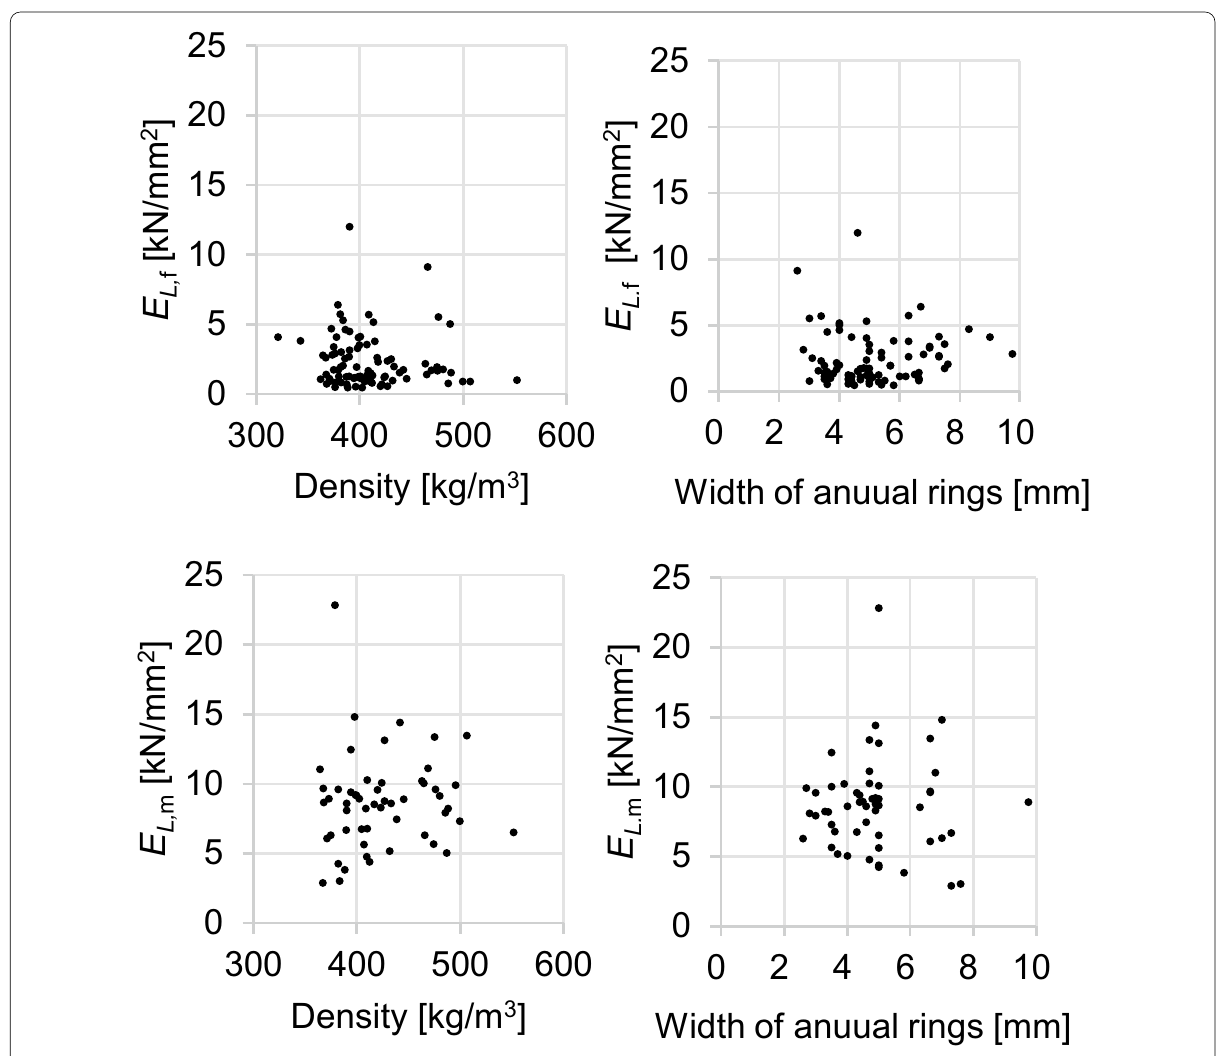
Fig. 9 E L, f , and E L, m against density and width of annual